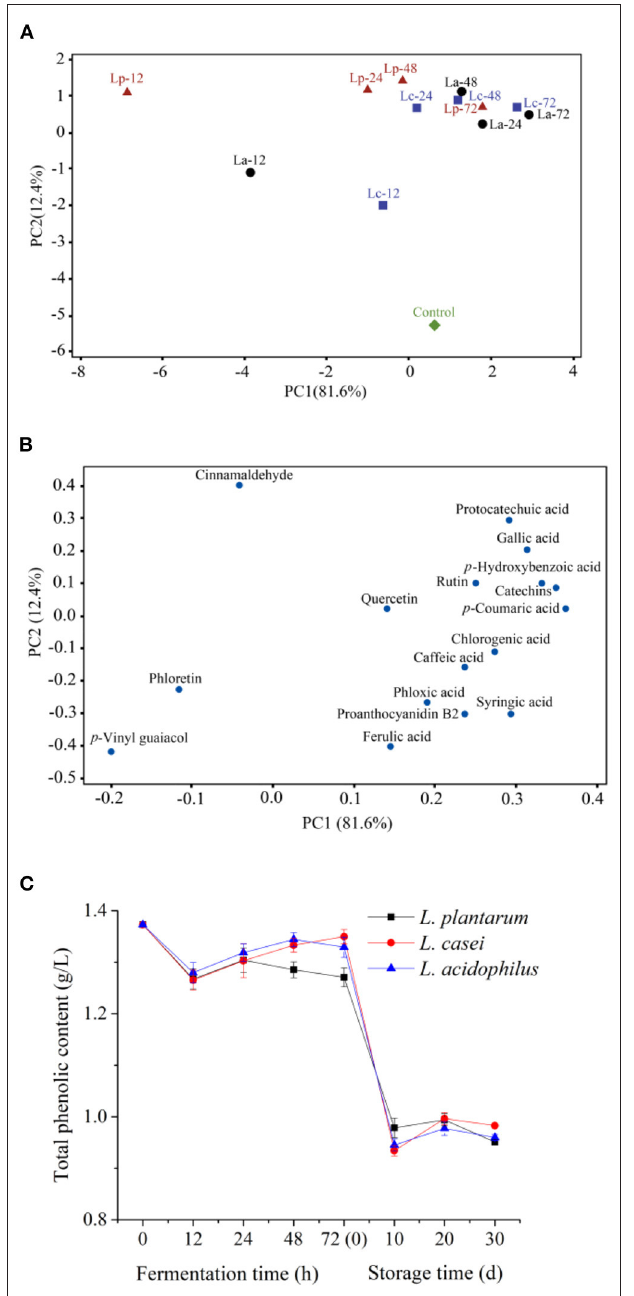
FIGURE 3 | Principal component analysis of phenolic profile in apple juice during fermentation by the three LAB strains [ (A) , the score plots; (B) , the loading plots] and changes in total phenolic content (C) . “Control,” Unfermented apple juice; “La,” Apple juice fermented by L. acidophilus ; “Lp”, Apple juice fermented by L. plantarum ; “Lc”, Apple juice fermented by L. casei . The number followed with the name of strain indicated the time of fermentation.